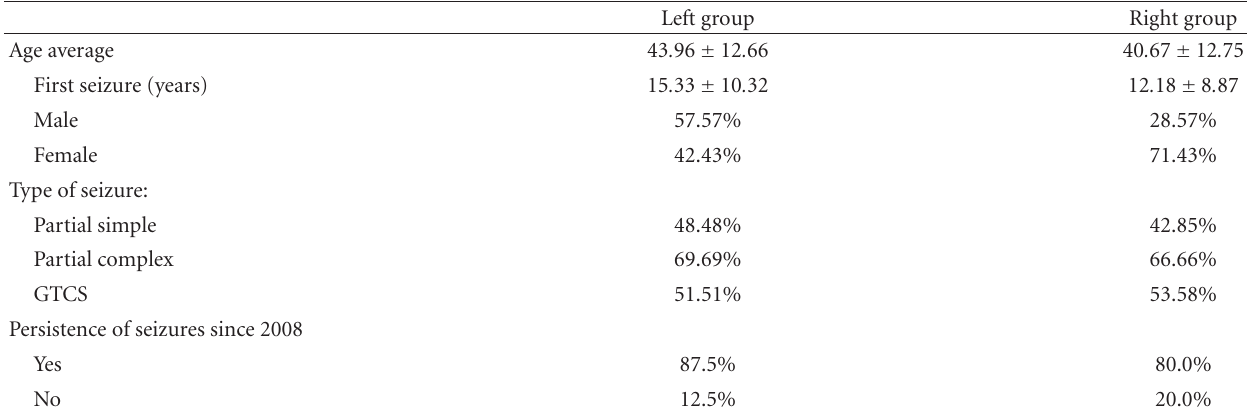
Table 1: Sample composition: patients, clinical